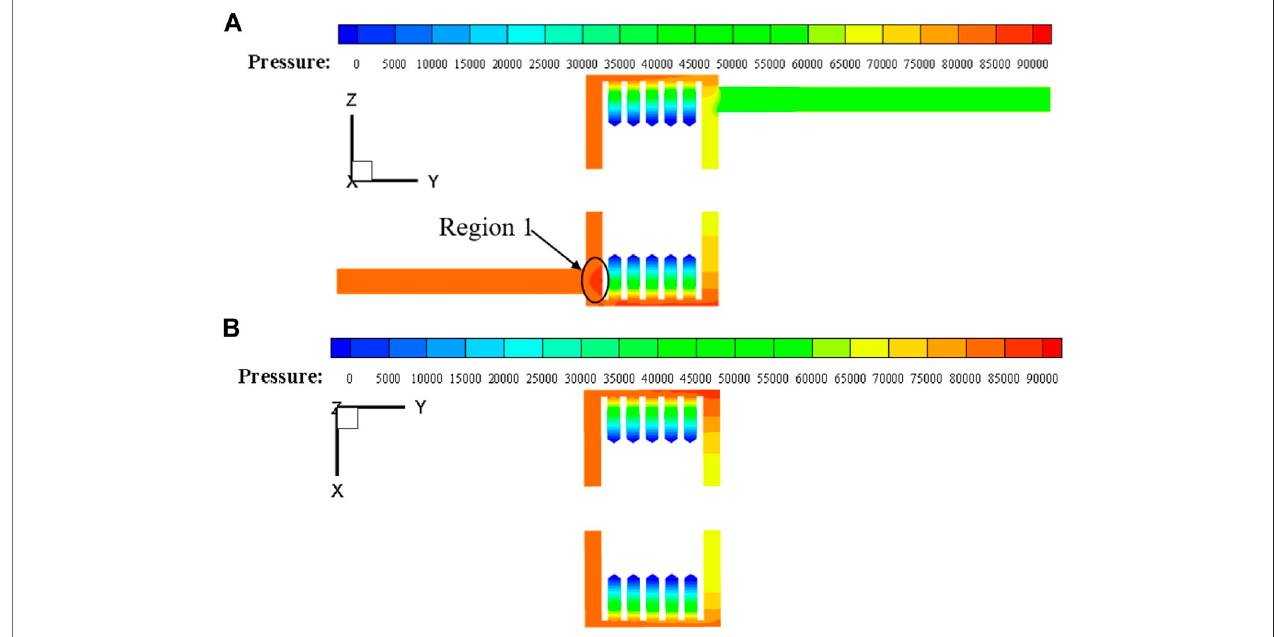
FIGURE 14 | Pressure distribution in RHCR: (A) pressure distribution at YZ cross-section, and (B) pressure distribution at YX cross-section.